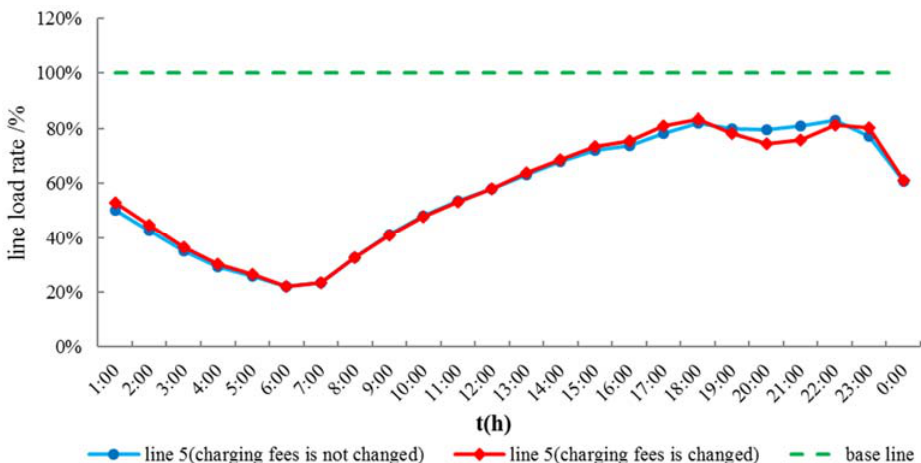
Figure A3. Line load rate of line 22 before and after adjustment for charging fees.